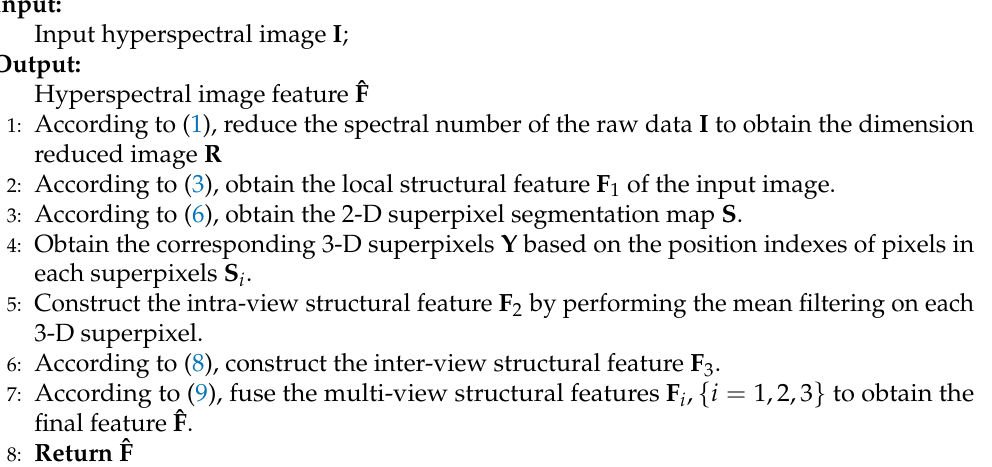
Algorithm 1 Multi-view structural feature